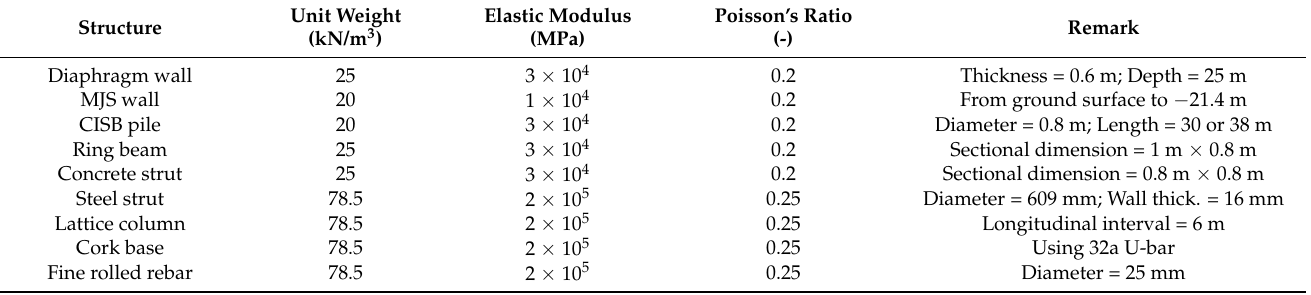
Table 3. Parameters required for the simulation of the excavation support system and the pipeline suspension structure.